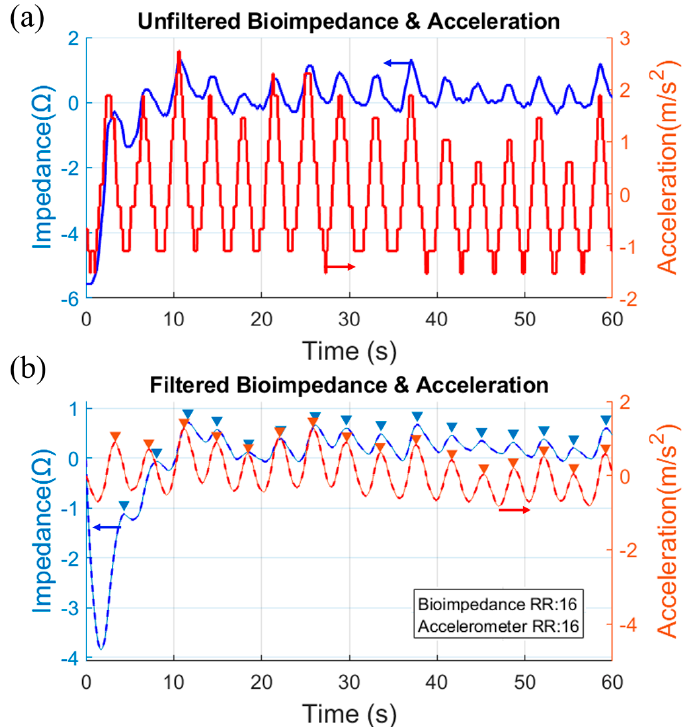
Figure 15. ( a ) Un fi ltered and ( b ) fi ltered bioimpedance and acceleration data of a male volunteer of Figure 15. ( a ) Unfiltered and ( b ) filtered bioimpedance and acceleration data of a male volunteer of age 33. age